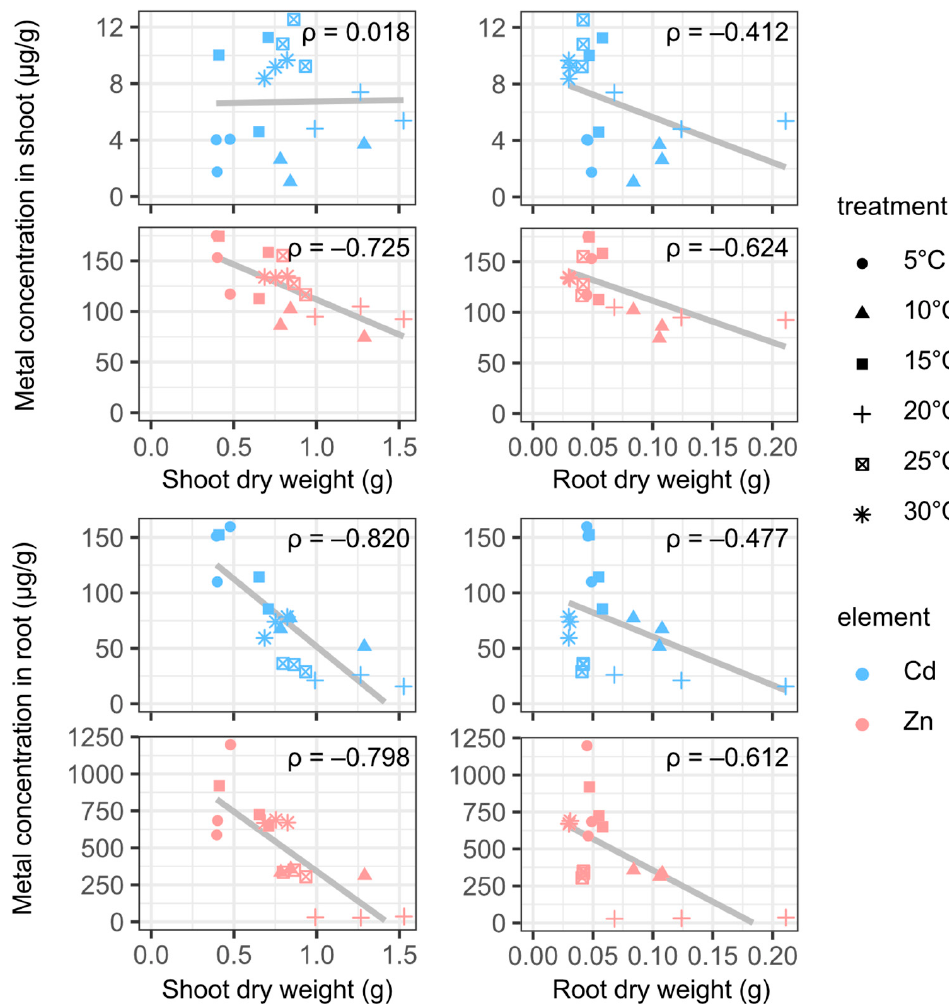
Figure 2. The correlation between the plant dry weight and metal concentration in the plant. ρ represents the Pearson correlation coefficient.